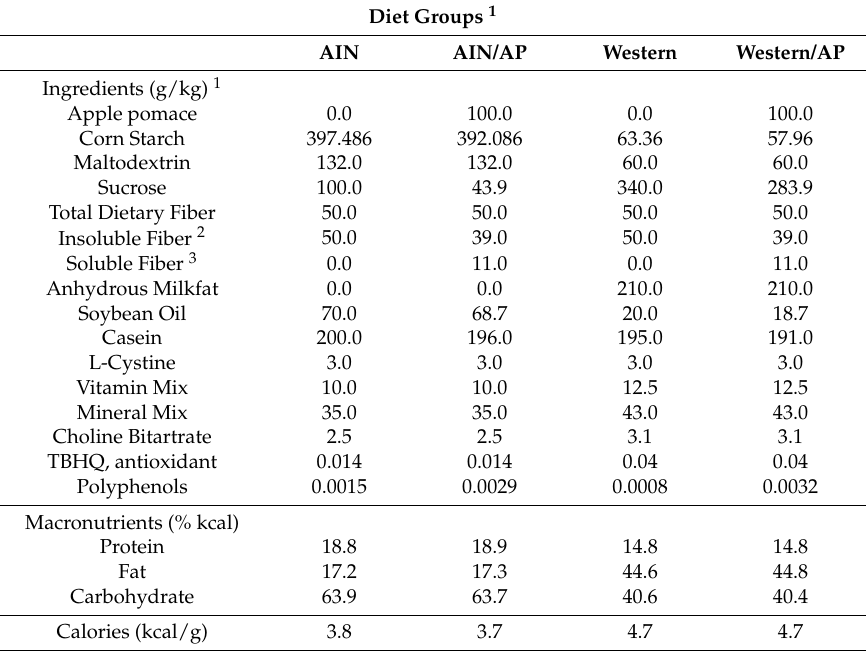
Table 1. Composition of rodent diets substituted with apple pomace (10% g/kg) fed to growing female rats.